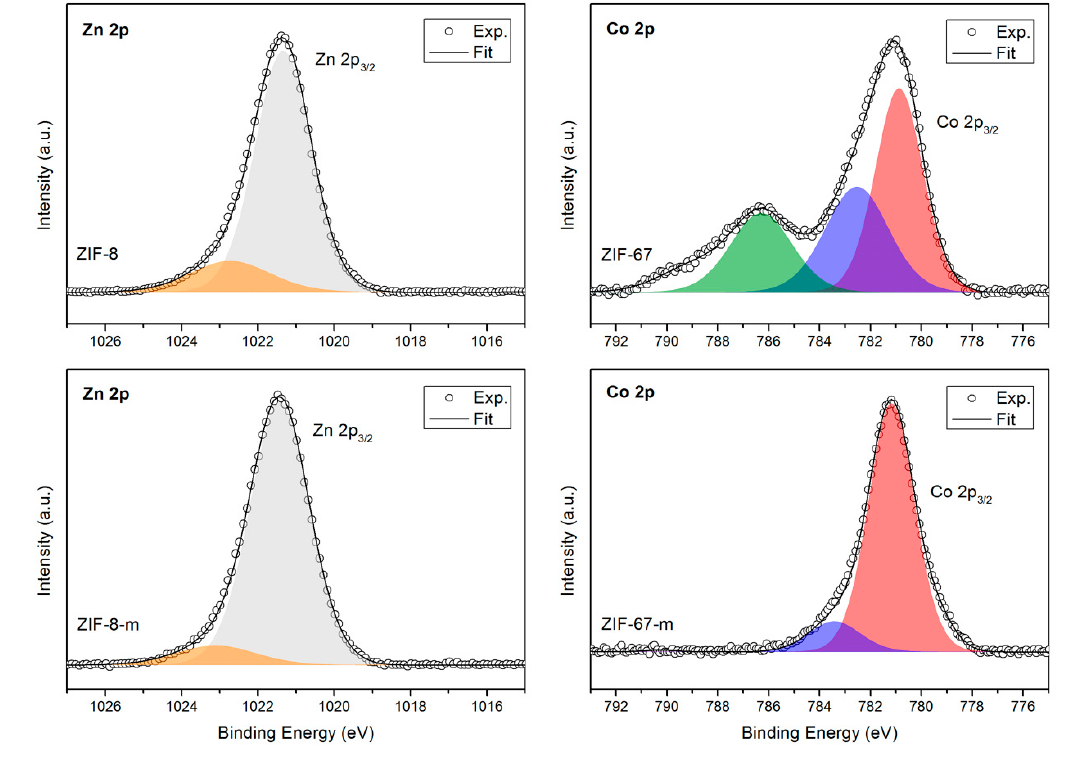
Figure A2. TGA-MS of sample ZIF-67. ( a ) In Ar, where m/z 82 is related with the 2-methylimidazole;